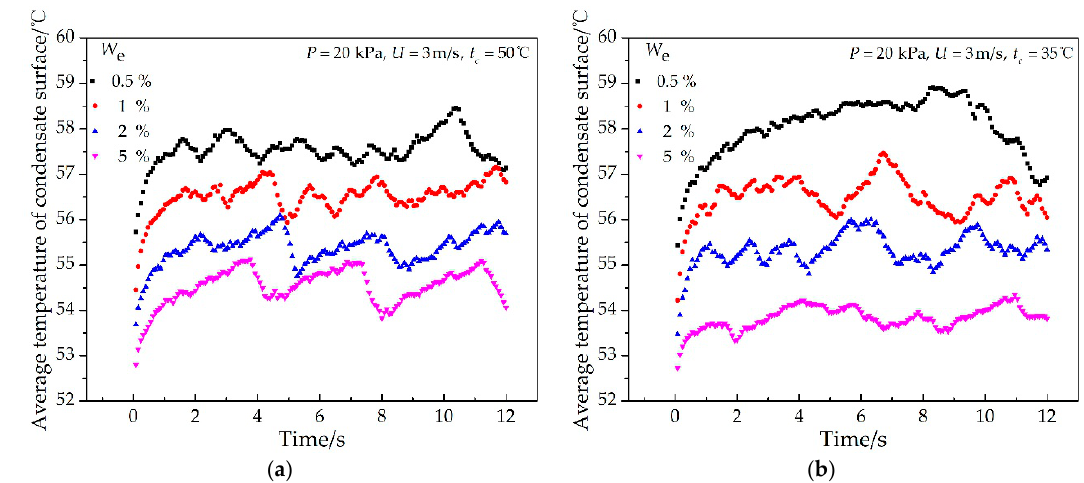
Figure 12. Effects of the ethanol vapor concentrations on the average temperature of the condensate surface at different times with the experimental conditions of ( a ) P = 20 kPa, U = 3 m/s, t c = 50 °C; ( b ) P = 20 kPa, U = 3 m/s, t c = 35 °C.